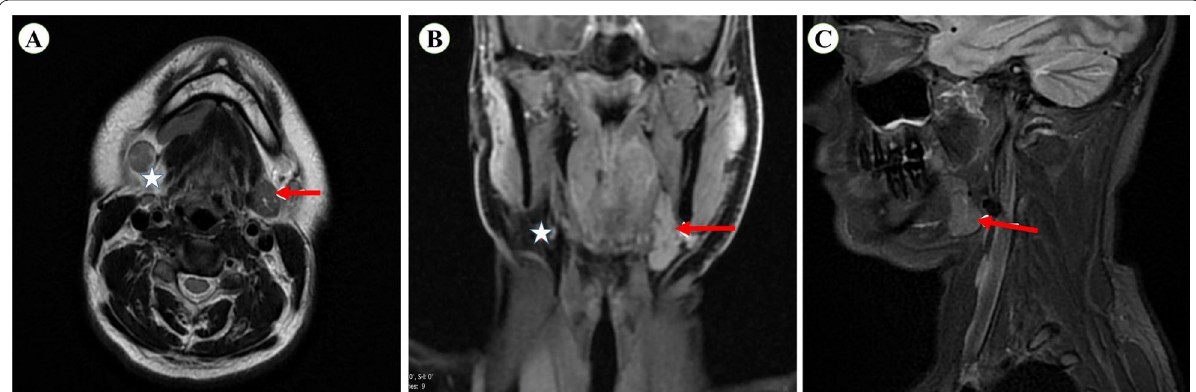
Fig. 2 MRI— A Axial T2W, B Coronal post-contrast T1W FS, and C Sagittal STIR images revealing the left submandibular gland of normal in size with normal signal intensity (red arrow— A , B , C ). The right submandibular gland was absent in right submandibular region (star— A , B )